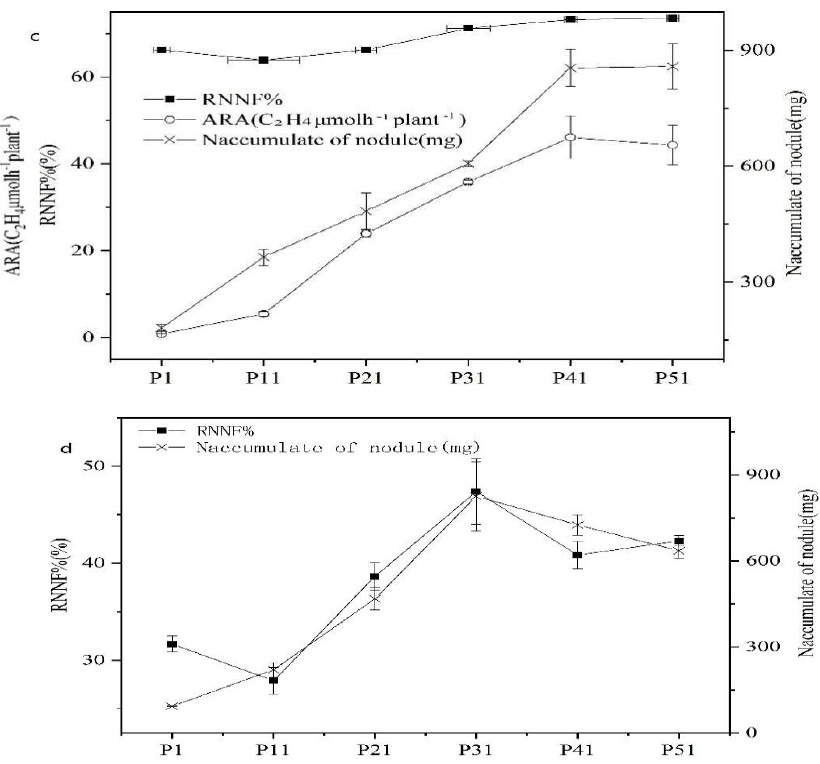
Figure 1. Variation trends of ARA, root nodule nitrogen fixation rate, and root nodule nitrogen fixation in soybean under different phosphorus supply levels. ( a ): initial flowering period; ( b ): initial pod stage; ( c ): filling period; ( d ): mature period.